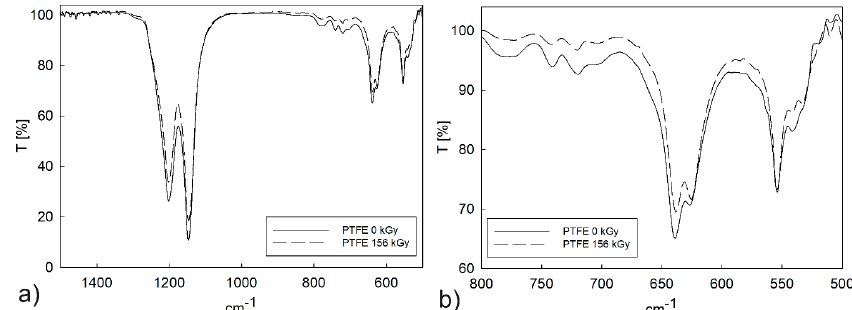
Figure 6. Fourier transform infrared spectroscopy (FTIR) spectra for pure PTFE in the initial state ( a ) and after a dose of 156 kGy electron beam irradiation ( b ).